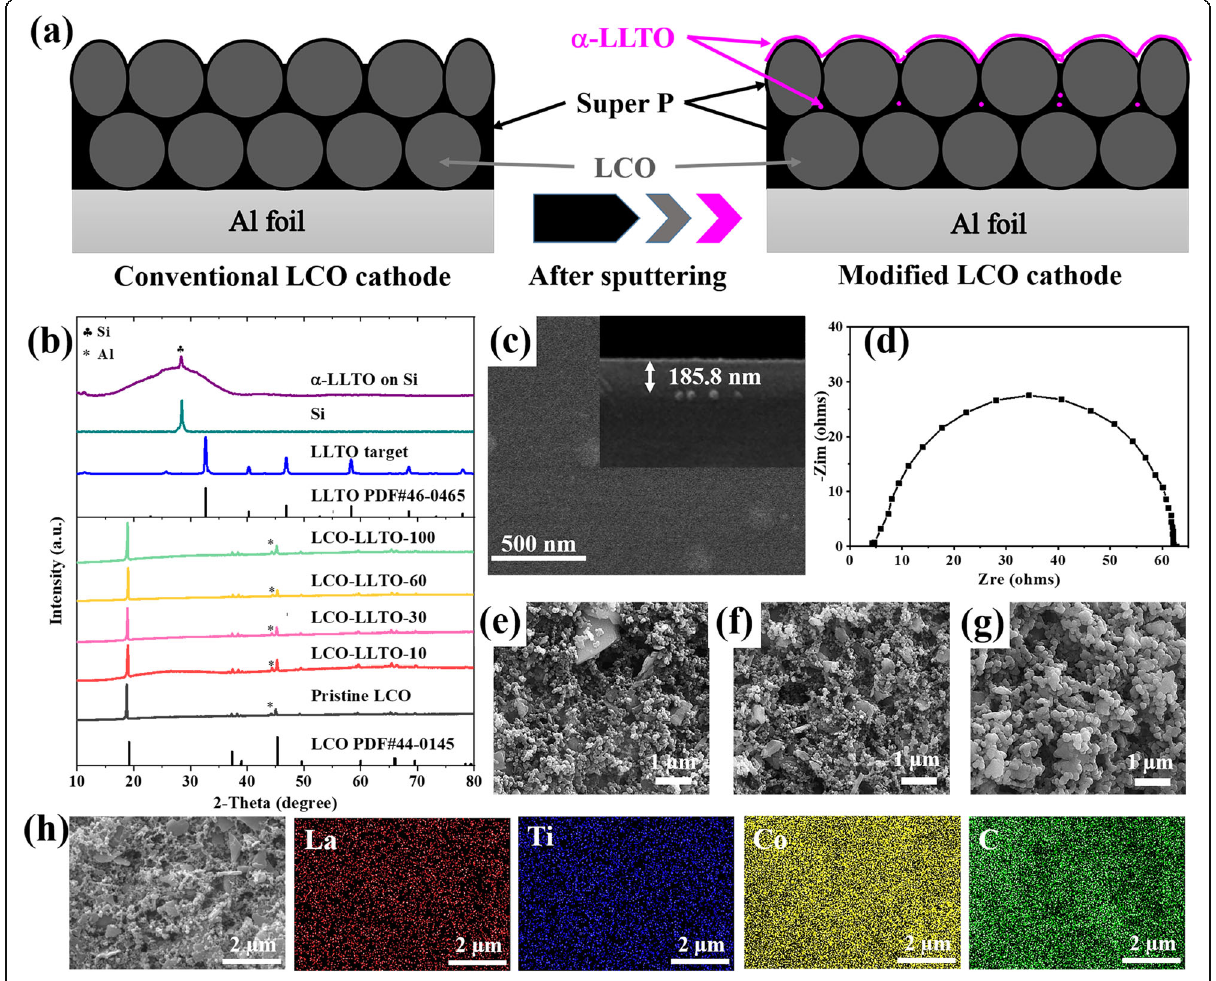
Fig. 1 a Schematic illustration of conventional LCO electrode and LCO electrode with an α -LLTO modification layer; b XRD patterns of LLTO target (blue line), Si substrate (dark-cyan line), α -LLTO thin-film on Si substrate (purple line), pristine LCO cathode (black line), and α -LLTO- modified LCO electrodes with different deposition time of LLTO (red line for 10 min, pink line for 30 min, yellow line for 60 min, and green line for 100 min); c Top- and side-view SEM images of LLTO thin-film on Si substrate; d EIS cure of LLTO film on Si substrate; e – g Top-view SEM images of e pristine LCO, f LCO-LLTO-10, and g LCO-LLTO-100; h EDS mapping of the surface of